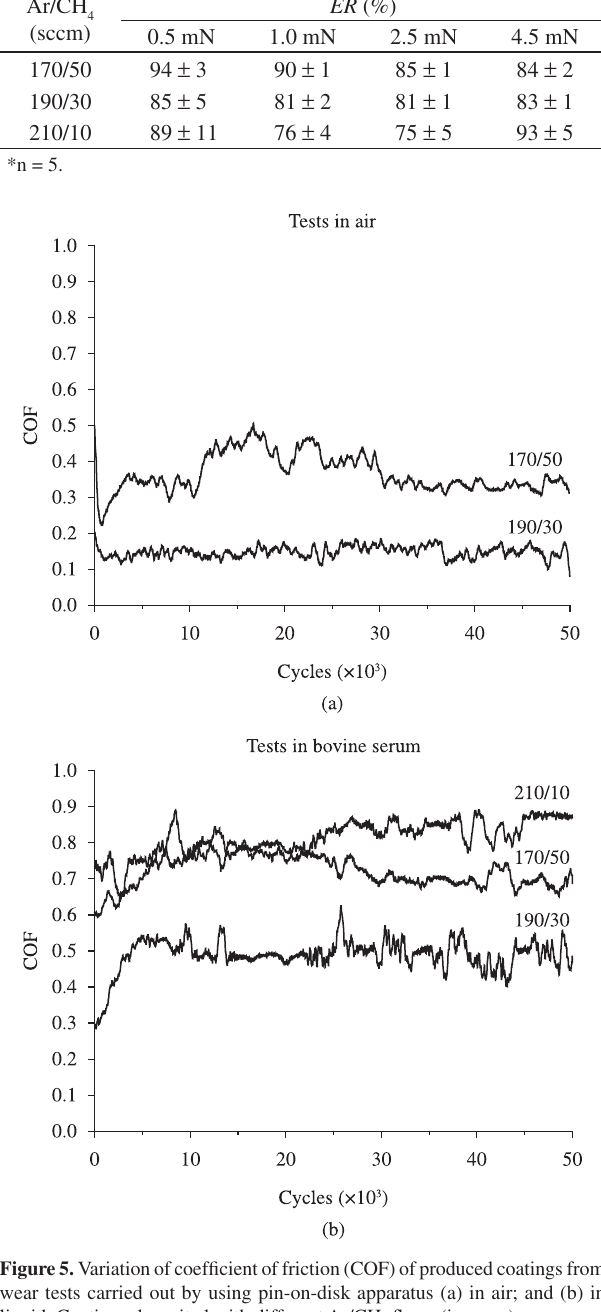
flows (in sccm). 4